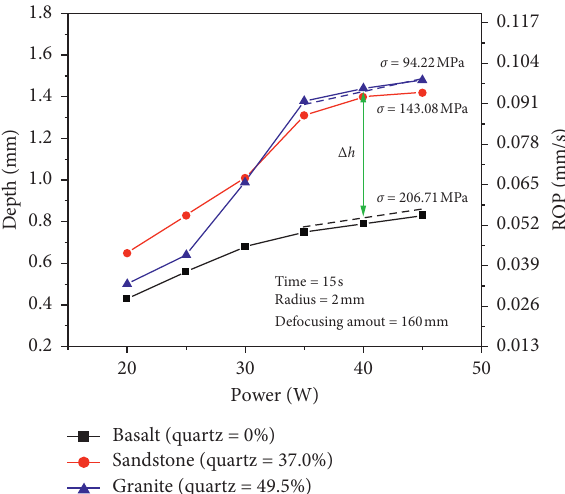
Figure 12: Effect of laser power on the rock perforation depth and ROP (rate of penetration).